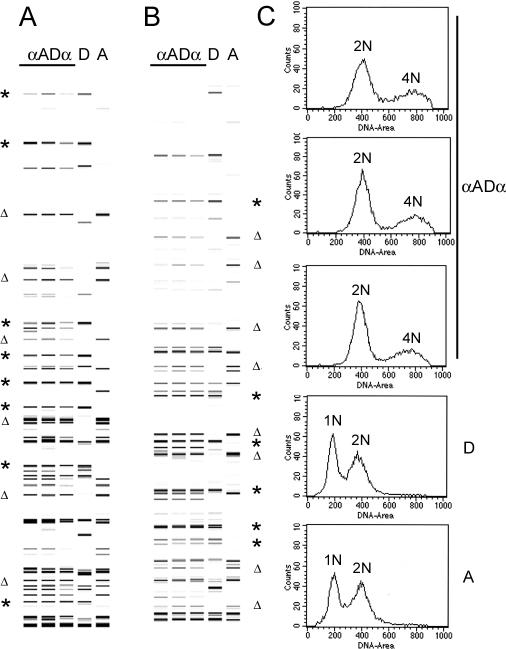
Environmental Isolates Are Diploid AD Hybrids(A and B) Environmental isolates 5–19, 6–20, 42–10, and serotype A (H99, Aα) and D (JEC21, Dα) control strains were analyzed by AFLP analysis using primer sets EAC (A) and ETG (B) as previously described [53,68]. Asterisks indicate serotype D–specific products, and triangles indicate serotype A–specific products. Environmental isolates 5–19, 6–20, 42–10 displayed a superimposition of the serotype A and D AFLP patterns, indicative of their AD hybrid nature.(C) Flow cytometry profiles of the environmental isolates 5–19, 6–20, 42–10, and the haploid control strains JEC21 and H99 after staining with the fluorescent dye propidium iodide. 1N, 2N, and 4N indicate nuclear content. The x-axis indicates fluorescence intensity reflecting the DNA content, and the y-axis indicates cell counts.